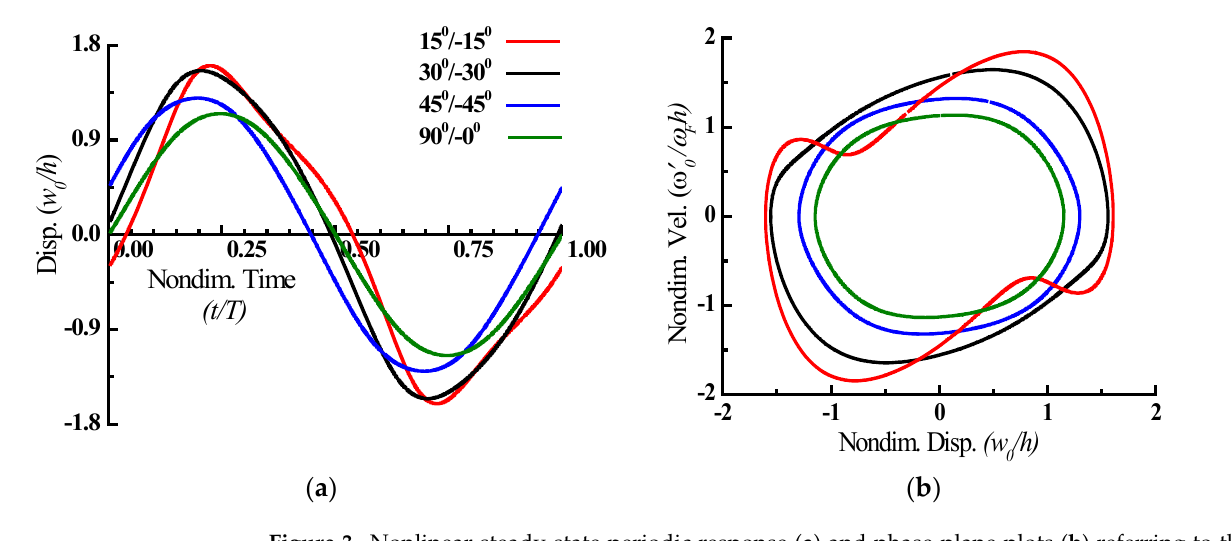
Figure 3. Nonlinear steady-state periodic response ( a ) and phase-plane plots ( b ) referring to the peak amplitude.